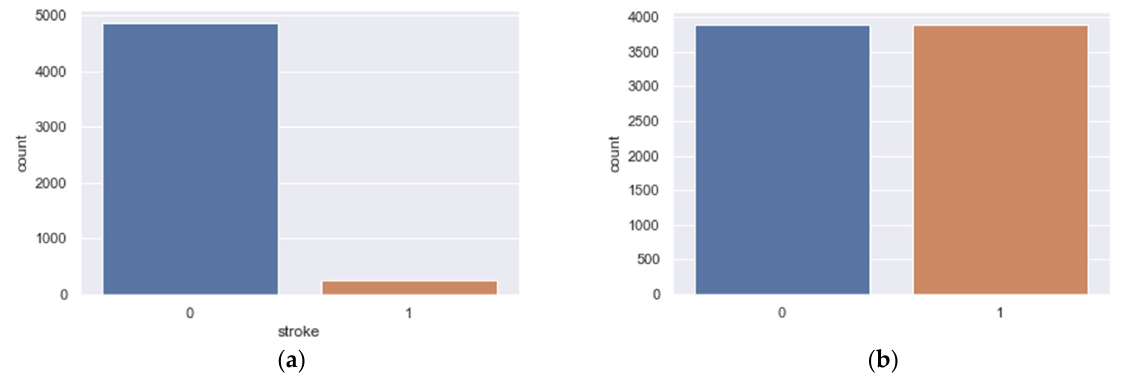
Figure 4. Class labels in stroke dataset ( a ) before applying SMOTE and ( b ) after applying SMOTE.